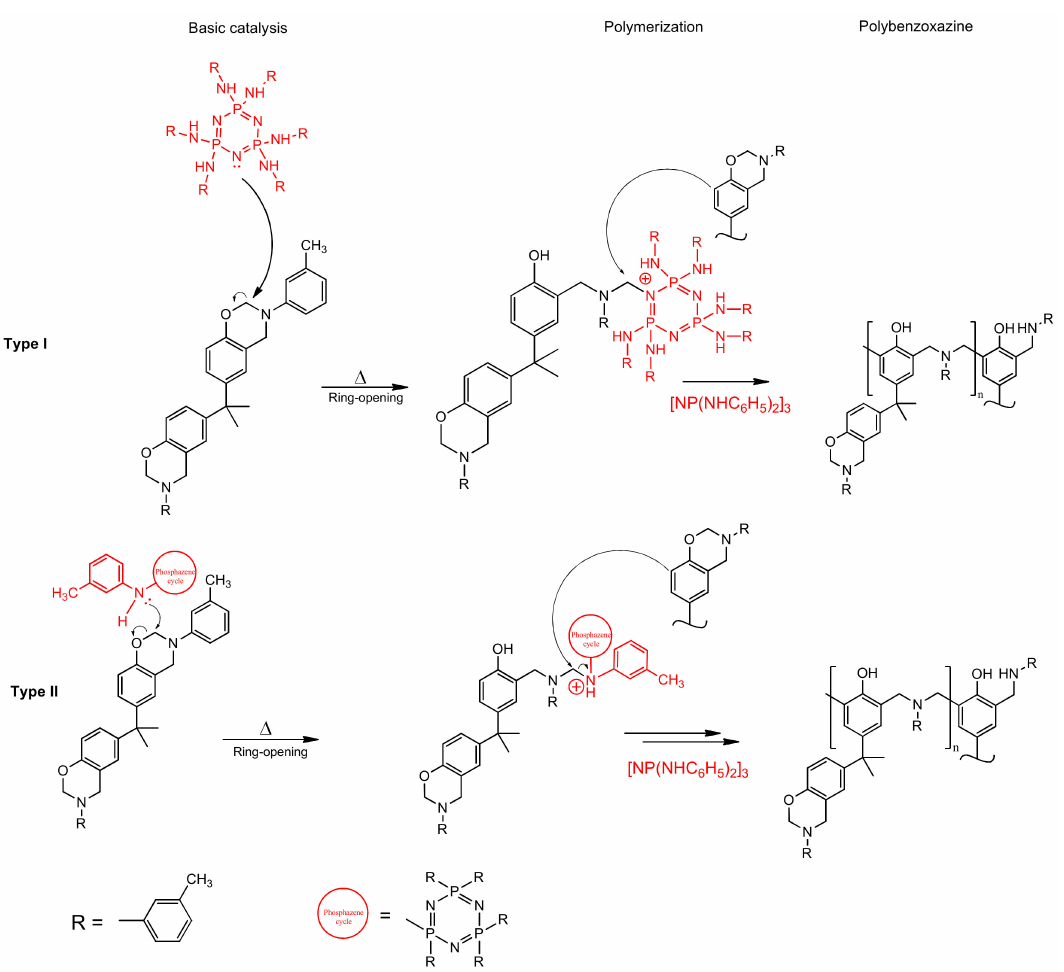
Figure 9. Proposed mechanism of benzoxazine polymerization catalyzed by PN-mt. The degree of curing under the given conditions increases with an increase in the concentration of PN-mt in the compositions. The presence of residual enthalpy indicates the incomplete cure of compositions. It should be noted that an increase in the concentration of PN-mt in the mixture, starting from 10 pbw, leads to the appearance of an